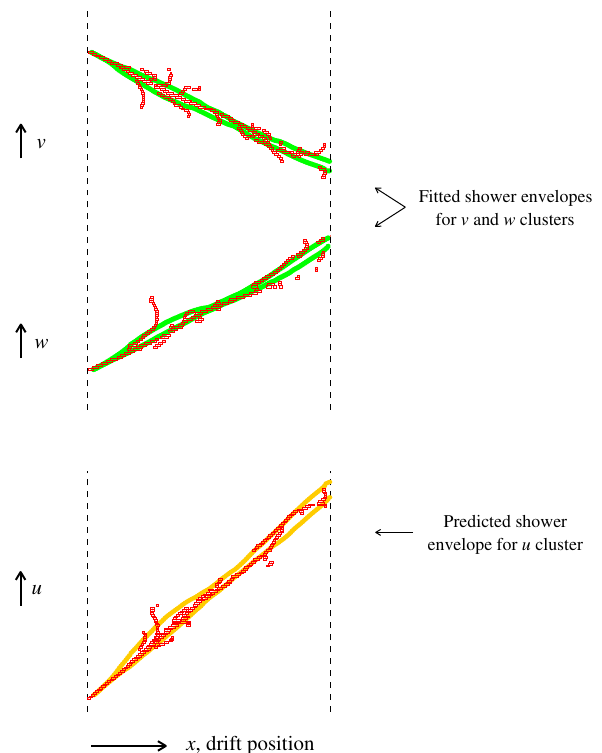
Fig. 8 The 3D shower reconstruction aims to identify the clusters rep- resentingthesameshowerineachofthethreereadoutplanes.Thehitsin candidate2Dclustersareshownasredboxes.Fitstothehitpositionsare used to characterise the spatial extent of the clusters. The fitted shower envelopes (green markers) from two clusters are then used to predict a shower envelope (orange markers) for the third cluster. The fraction of hits in the third cluster enclosed by the predicted envelope is calculated. Predictions made using all cluster combinations ( u ,v → w ; v,w → u ; u ,w → v ) are used to decide whether to add the three clusters to a new shower